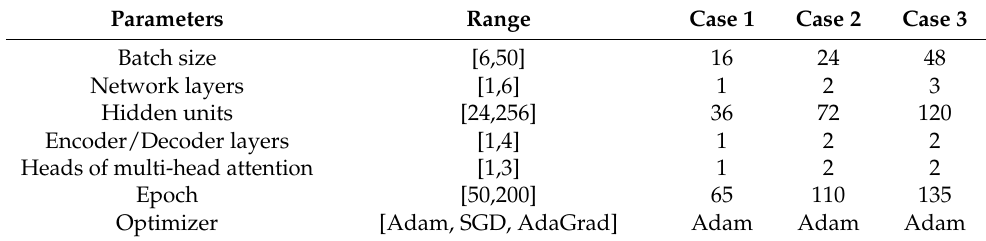
Table 2. Bayesian optimization hyperparameter space and search results. Parameters